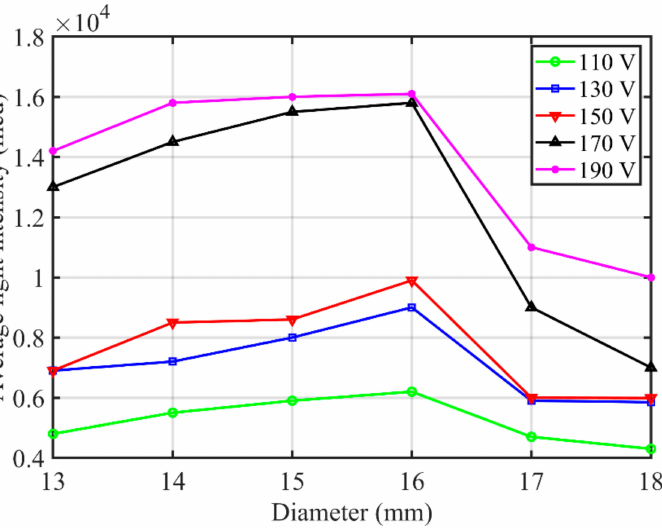
Figure 8. The average light intensities with metallic rods at different conditions.